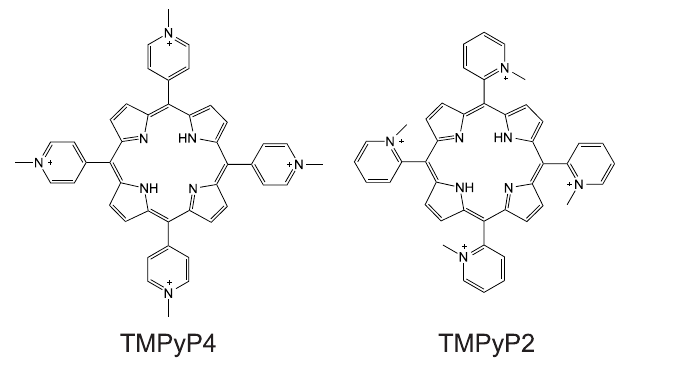
Fig 1. Molecular structures of TMPyP4 and